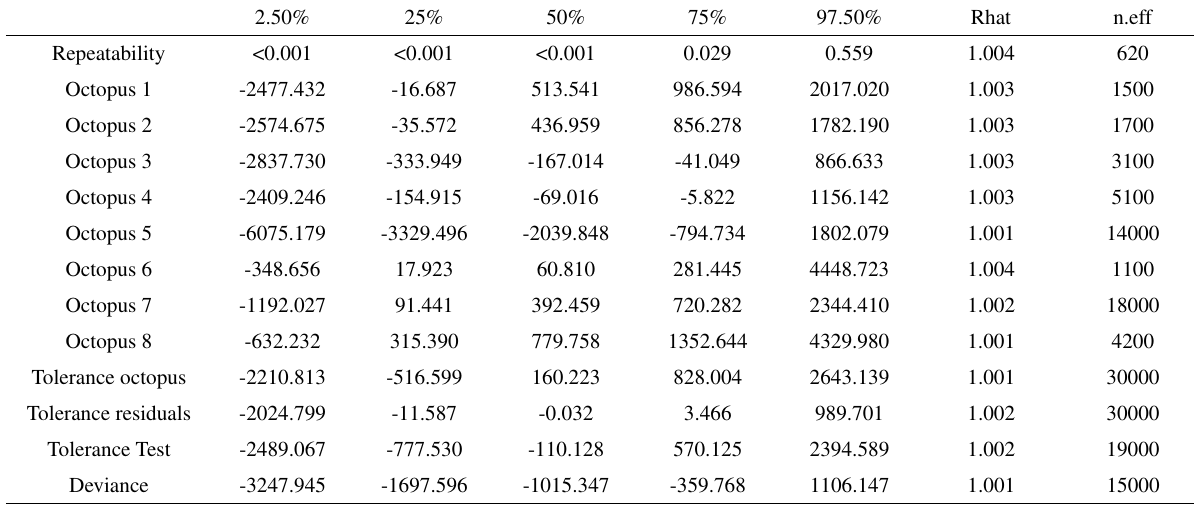
Table S1. – Distribution of the main parameters “posteriors” on estimated repeatability and mean latency to first capture (see Eq. 1): the median (or percentile 50%), 95% Bayesian confidence interval (BCI; percentiles 2.5 and 97.5%), the convergence index of the chains (at convergence, Rhat=1) and the number of effective iterations